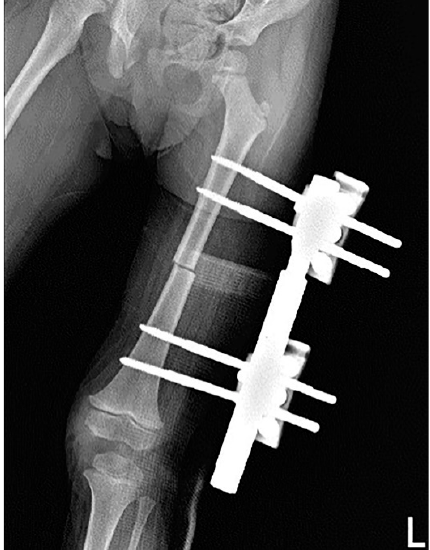
Figure 3. Postoperative x-ray of left femur after osteotomy and monofixator applied (L =